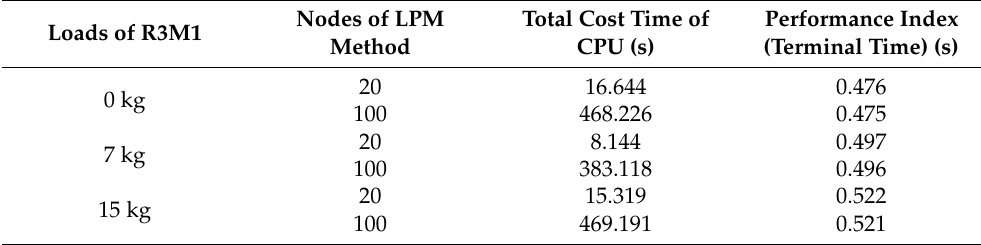
Table 2. Comparison of results of the improved method with different loads. Loads of